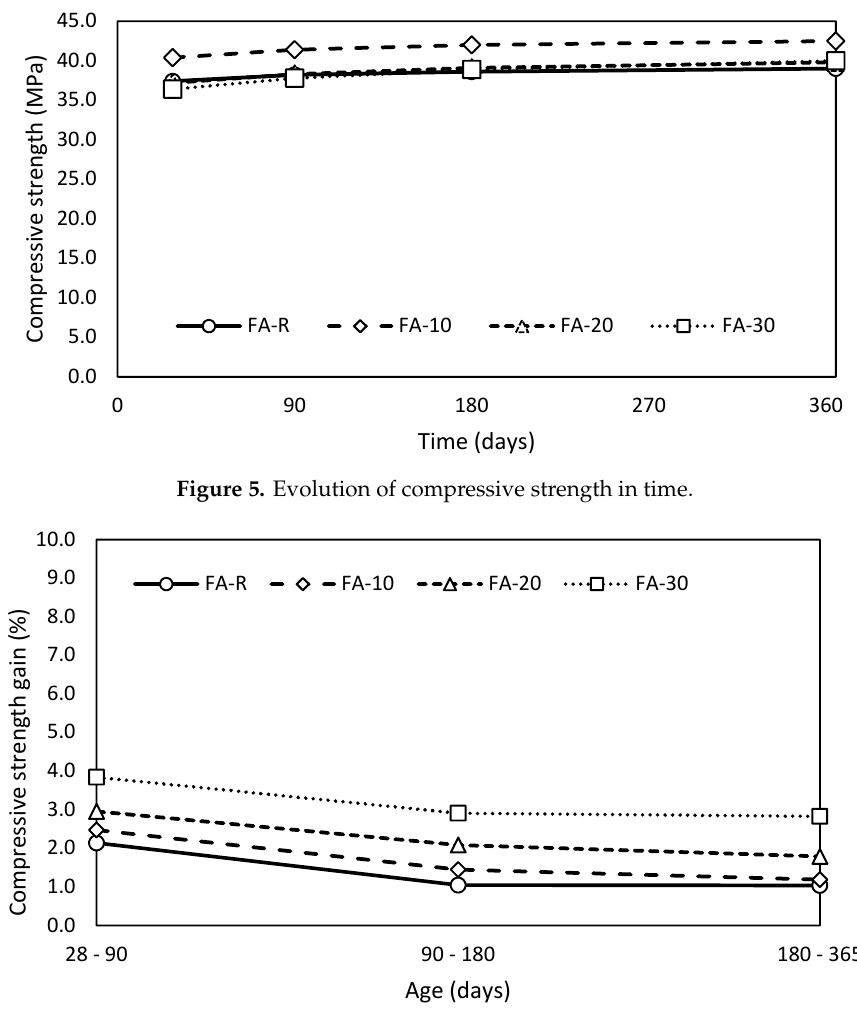
Figure 6. Gain of compressive strength in time.